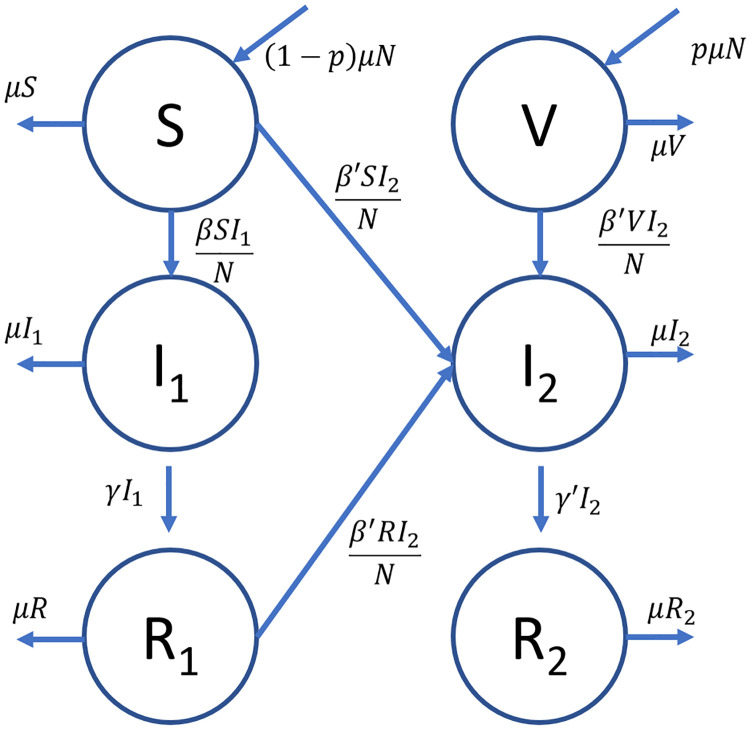
Compartment diagram for the emerging disease model.The transitions between compartments, together with the corresponding rates, are described by the arrows directed in and out of each compartment.